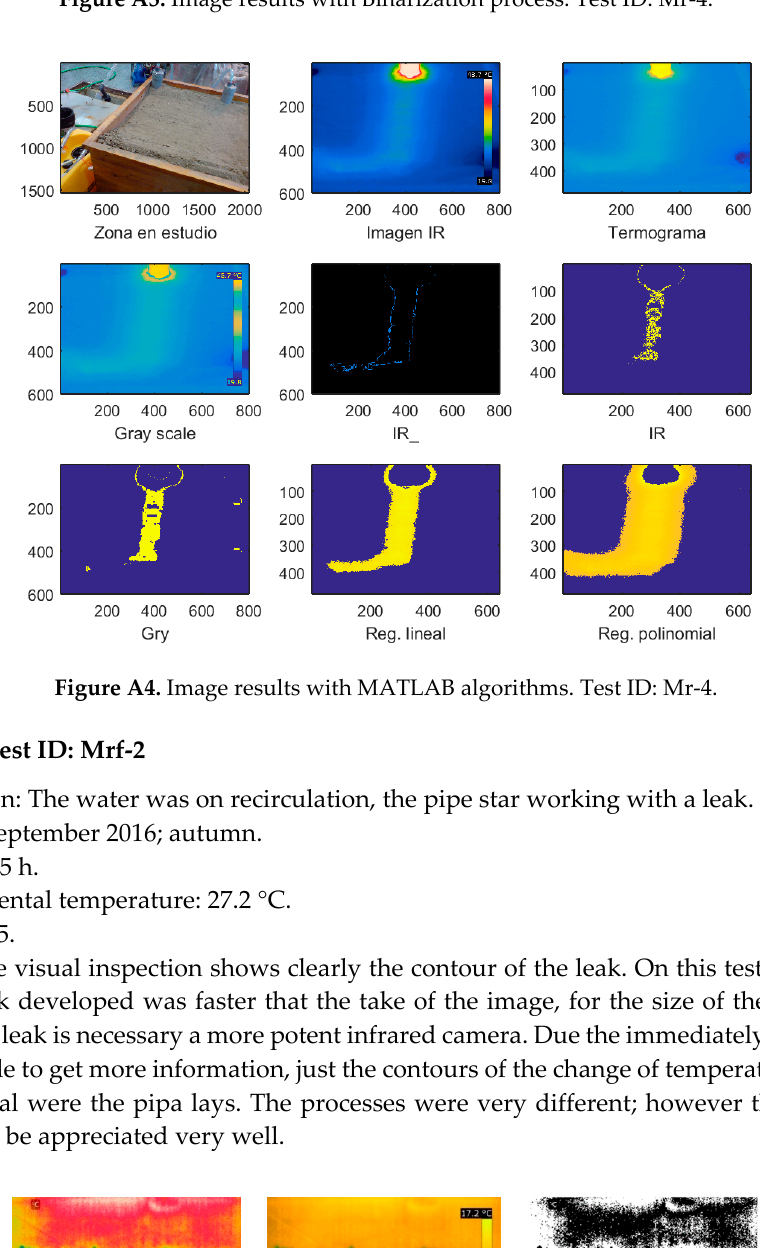
Figure A3. Image results with Binarization process. Test ID: Mr-4.